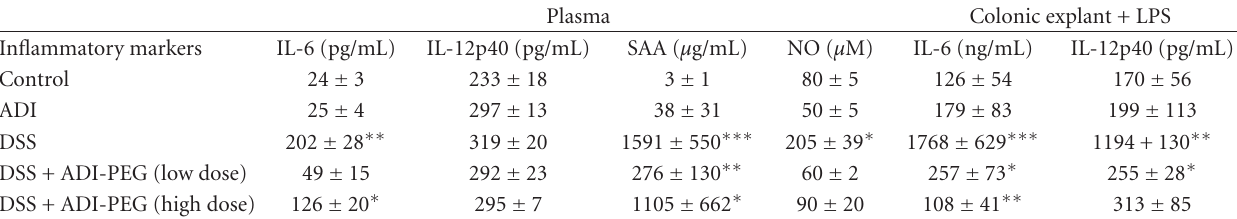
Table 1: IL-10 deficient-mice: comparison of inflammatory markers in plasma and colonic explants in IL-10-deficient (IL-10 − / − ) mice treated with DSS and ADI-PEG versus sham controls. ∗ P < 0 . 05, ∗∗ P < 0 . 01, and ∗∗∗ P < 0 . 001.